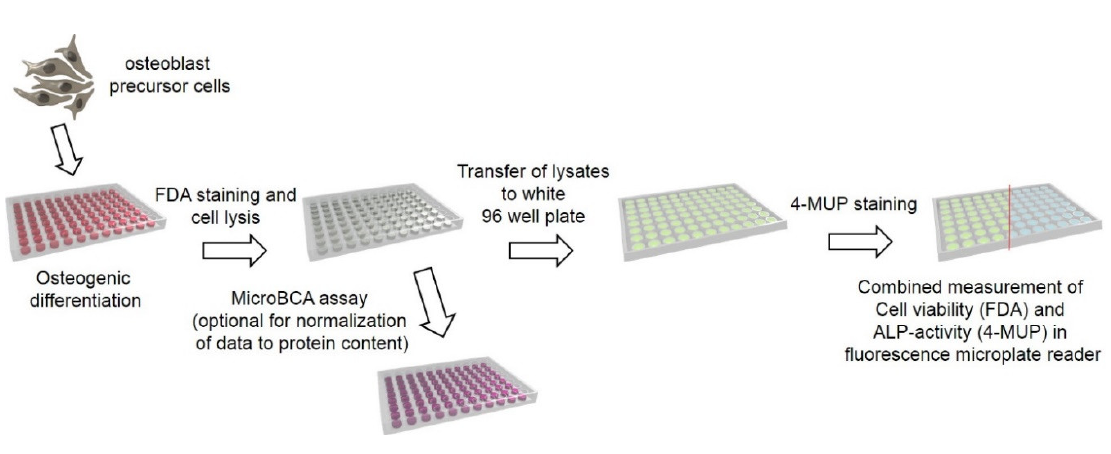
Figure 1. Schematic overview of the protocol.